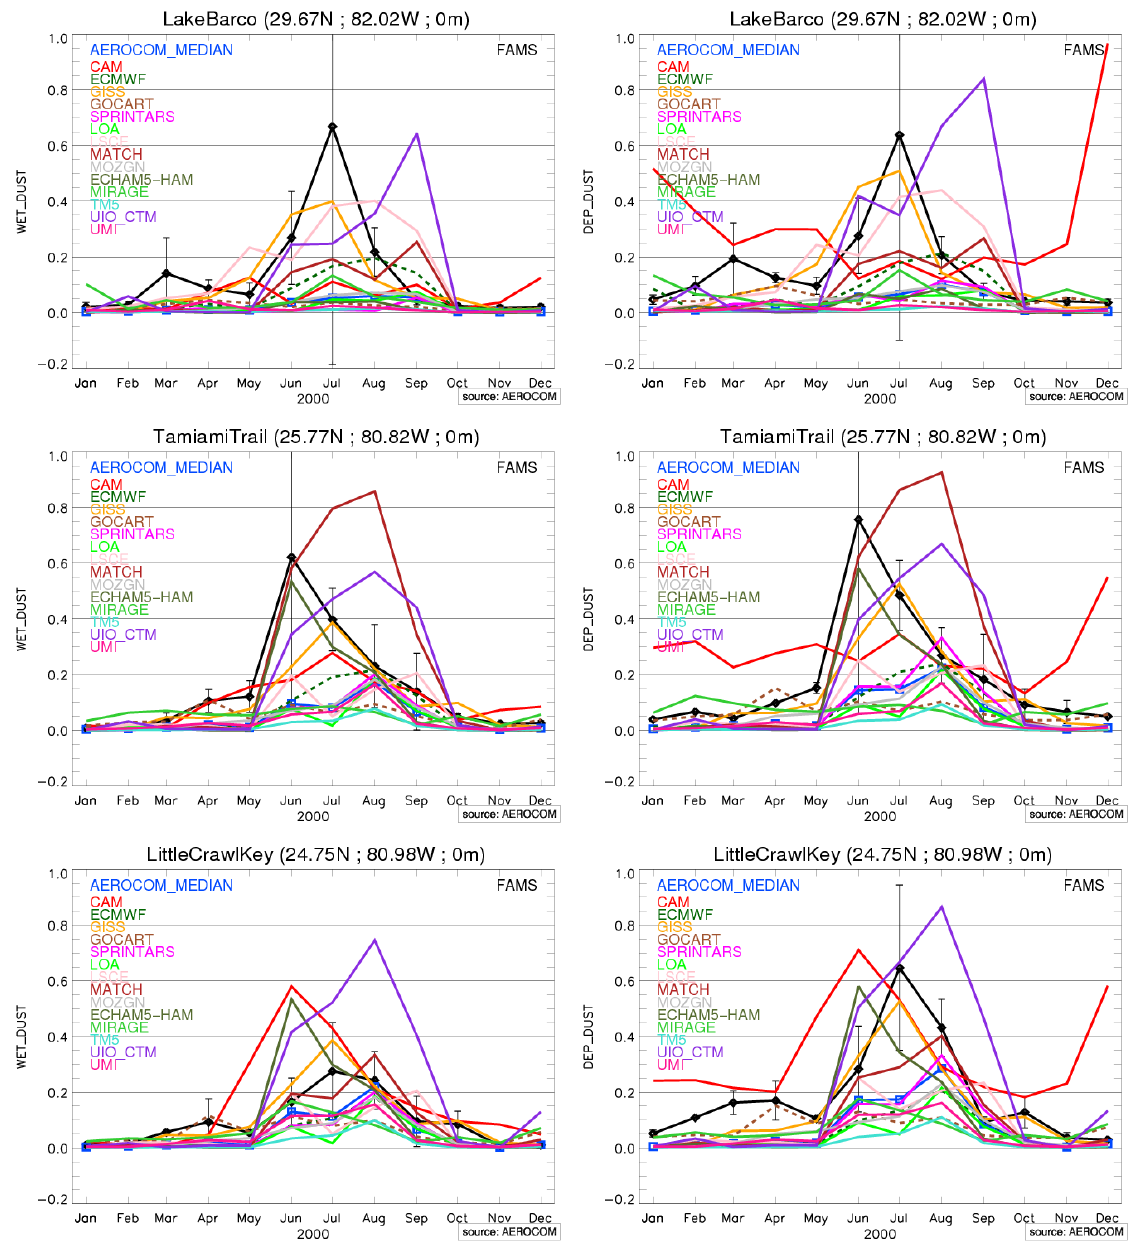
Fig. 3. Modeled and observed wet (left) and total (right) dust deposition rates at three sites from the Florida Atmospheric Mercury Study (FAMS) network: Lake Barco (LB), Tamiami Trail (TT), and Little Crawl Key (LCK). The black line is the mean of the 3 years of FAMS data from 1994–1996. Vertical lines correspond to one standard deviation of the 3yr average. Units are gm − 2 month − 1